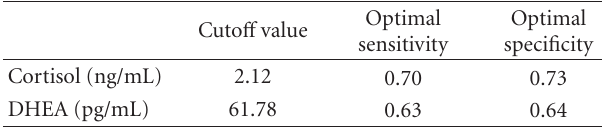
Table 6: Cuto ff values for cortisol and DHEA in saliva for optimal sensitivity and specificity obtained from ROC curve for CAL levels in